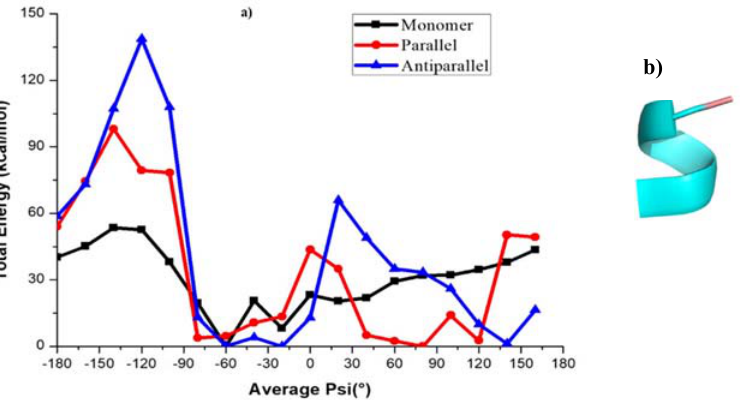
Figure 5. ( a ) Calculated total energy of conformations at different ψ angles using the PM7 level of theory for KLVFFA. ( b ) The helical conformation at first minimum ( − 60°) of KLVFFA.